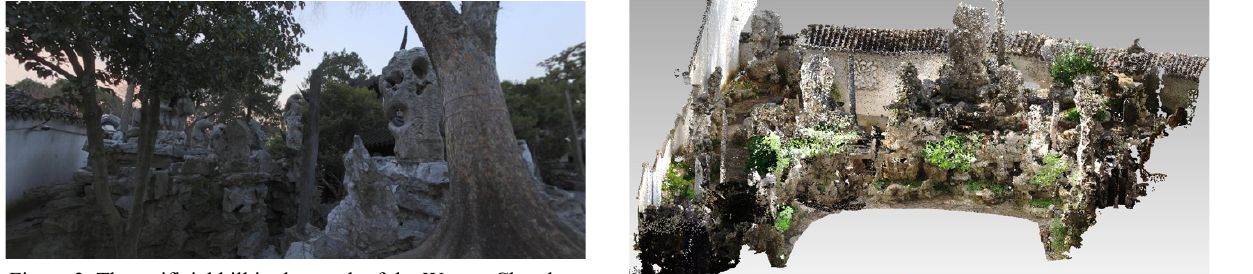
Figure 3. The artificial hill in the south of the Woyun Chamber.